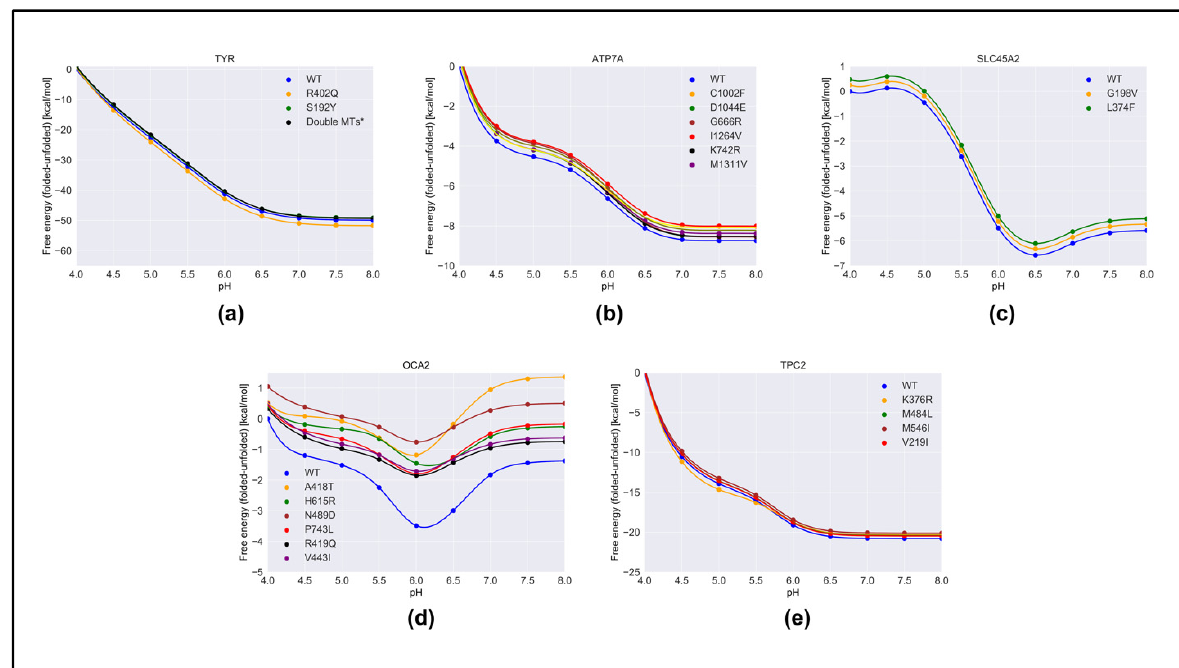
Figure 4. The pH dependence of the folding free energy of wild-type proteins and their mutants from minimized structures within pH range 4–8. ( a )TYR; ( b ) ATP7A; ( c ) SLC45A2; ( d ) OCA2 & ( e ) TPC2.